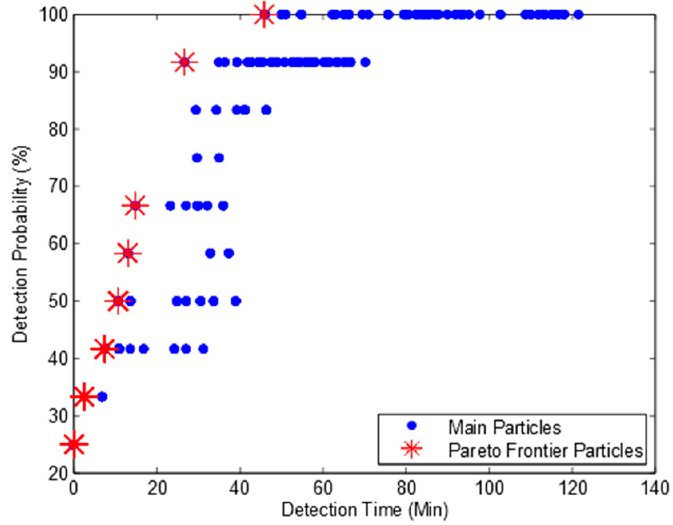
Figure 3. Pareto frontier of enumeration search.